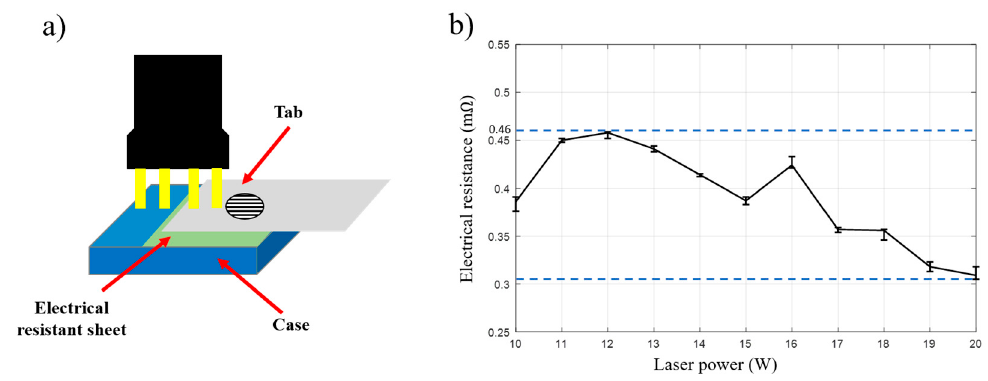
Figure 13. ( a ) Four-wire method measurement; ( b ) electrical resistance of the welds.